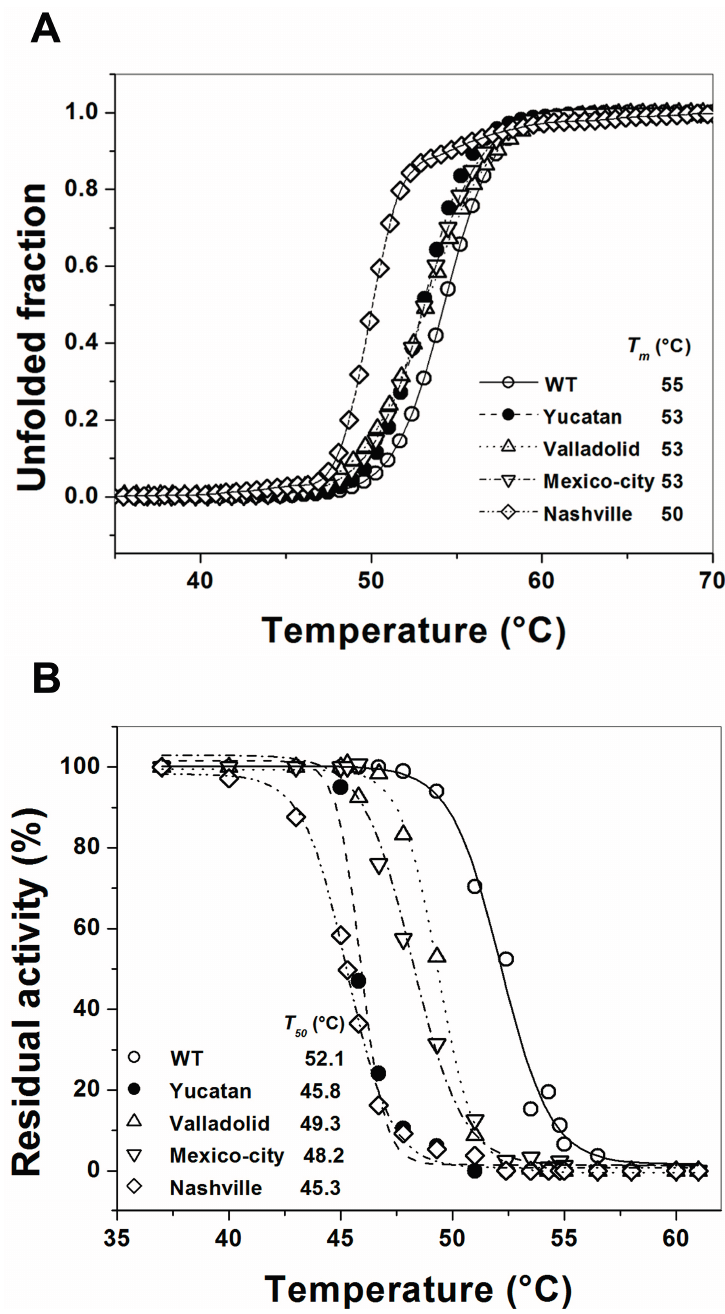
Figure 4. Thermal stability of human G6PD enzymes. ( A ) Thermal unfolding of WT G6PD and the mutants (0.8 mg/mL) in 25 mM NaPO 4 pH 7.4 was monitored by recording the change in CD signal at 222 nm at different temperatures ranging from 20 to 90 °C. The unfolded fraction of protein and the T m (melting temperature midpoint of the transition values) (inset) were calculated as previously reported [22]; and ( B ) Thermal inactivation assays of WT G6PD and the mutants after incubation for 20 min at the indicated temperature. The T 50 (temperature where 50% of its original activity is retained) after incubation at different temperatures for 20 min is shown. In all cases, 200 ng of total protein was used. The assays were performed in duplicate; standard errors were lower than